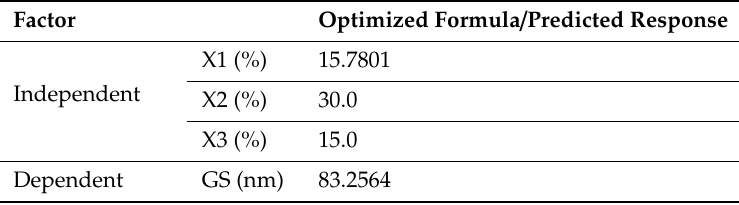
Table 4. Optimized nanoemulsion formula and predicted responses.